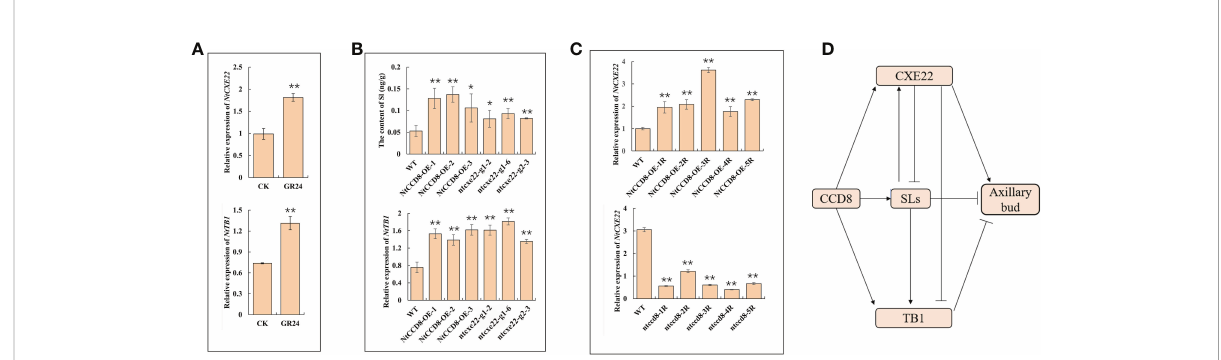
FIGURE 10 The veri fi cation of NtCXE22 involved in regulating SLs. (A) Transcriptional response of NtCXE22 and NtTB1 to GR24 (strigolactone analog) by qRT- PCR. (B) Expression level of NtTB1 and the content of SL in the axillary buds and roots of the wild type, NtCCD8 -OE, and ntcxe22 plants by qRT-PCR. (C) Expression level of NtCXE22 were monitored in the roots of NtCCD8 mutant ( ntccd8) and NtCCD8 -OE plants by qRT-PCR. (D) The regulatory network between the CXE22, CCD8, SL, and TB1. Data are presented as means ± SDs (n = 3). *P < 0.05, **P < 0.01 (signi fi cant difference relative to controls based on Student ’ s